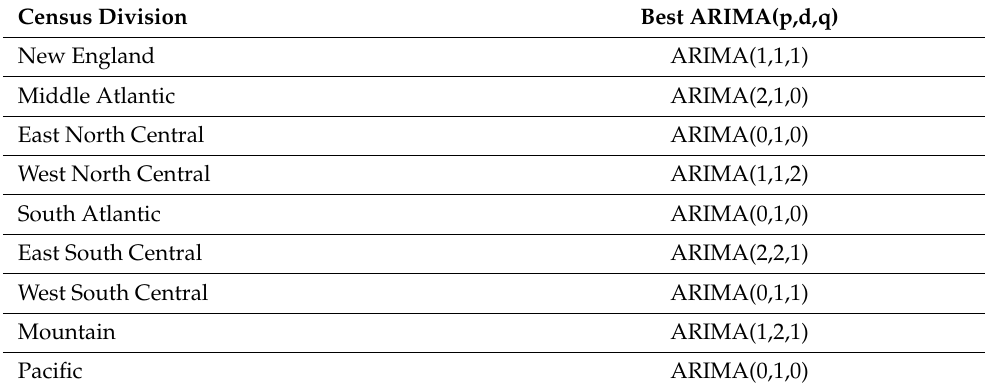
Table 3. Best ARIMA(p,d,q) for females.